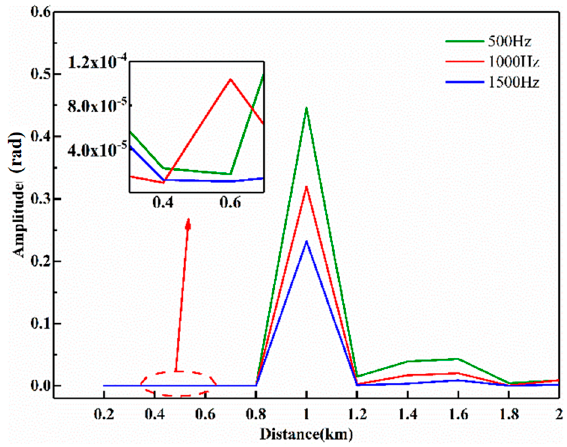
Figure 14. Amplitudes of 500 Hz, 1000 Hz and 1500 Hz in filtered phase curve along the optical fiber. The amplitudes of three frequency components are largely weakened at no vibration